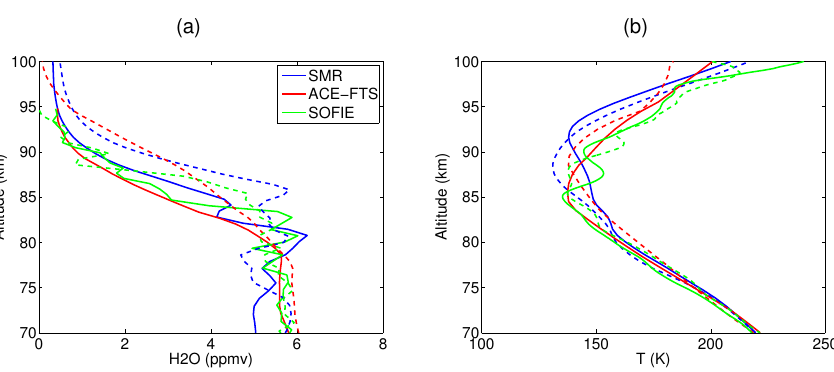
Figure 12. (a) Water vapour profiles from orbit 51226 at 68 ◦ N, 81 ◦ E (dashed lines) and 68 ◦ N, 63 ◦ W (solid lines) from SMR (blue), with collocated ACE-FTS (red) and SOFIE (green) measurements. (b) The corresponding temperature